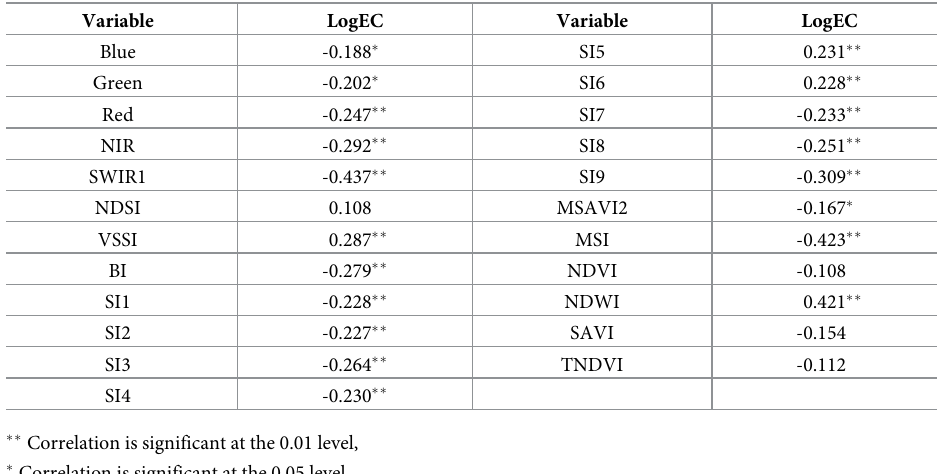
Table 5. Pearson correlation between soil EC and Landsat TM band, and index reflection values. Variable